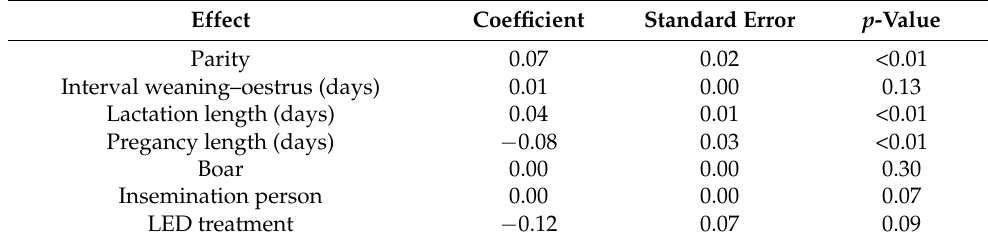
Table 4. Multivariate analysis. Dependent variable: total piglets born N = 2.567 multiple R 0.12 squared multiple R